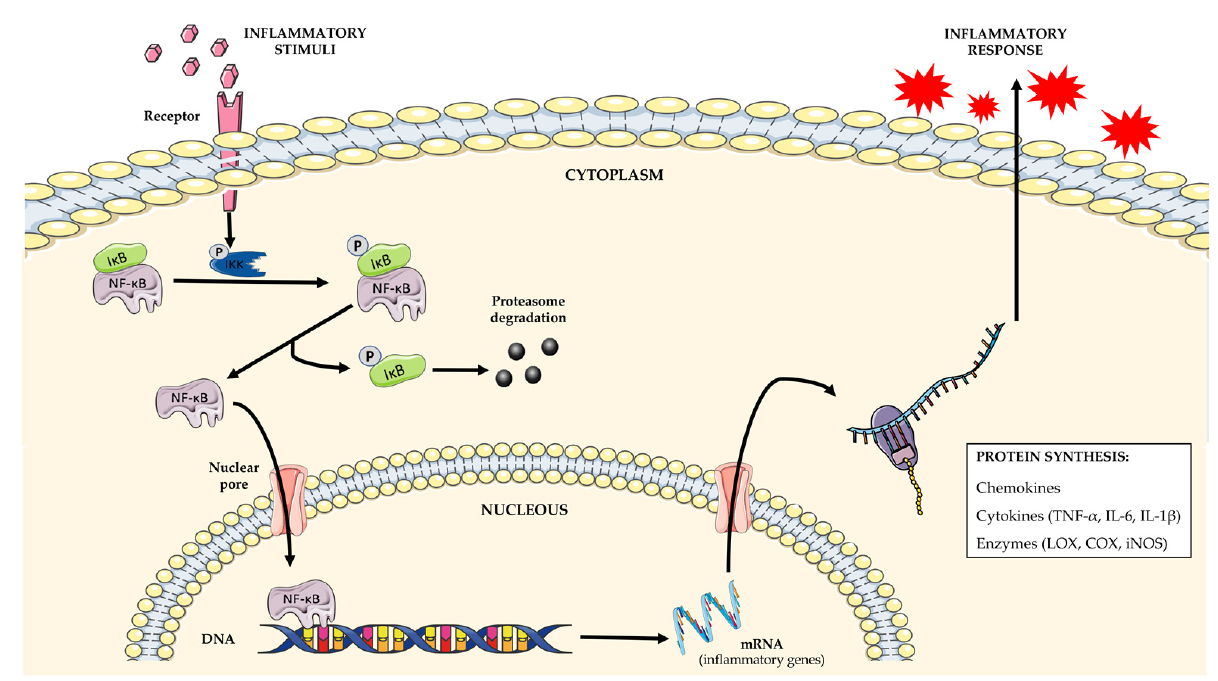
Figure 4. The implication of NF- κ B signaling pathway in inflammation. The inflammatory stimulation of a cell may lead to IKK phosphorylation and activation which, in turn, may lead to the phosphorylation of the I κ B/NF- κ B complex retained in the cytoplasm. The I κ B is degraded by the proteasome, while the NF- κ B transcription factor can enter into the nucleus and bind DNA to initiate the transcription of some targeted genes implicated in the inflammatory response.